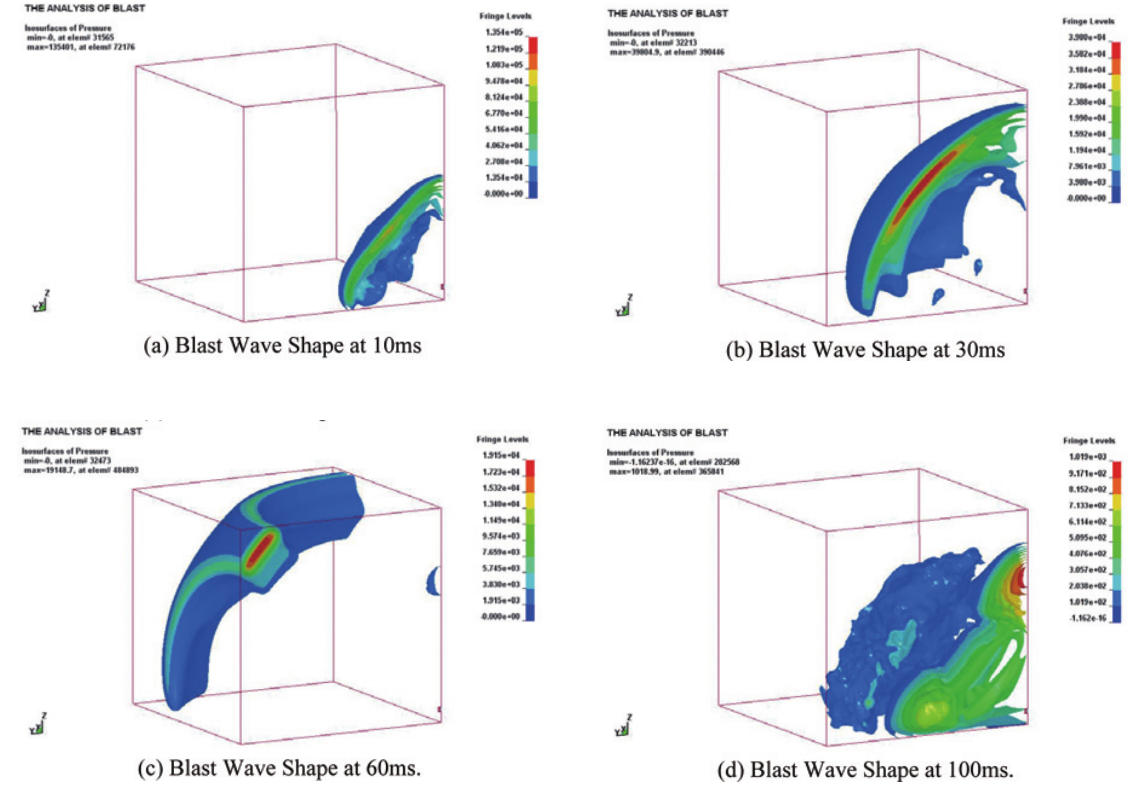
Fig. 3. Propagation of blast wave.